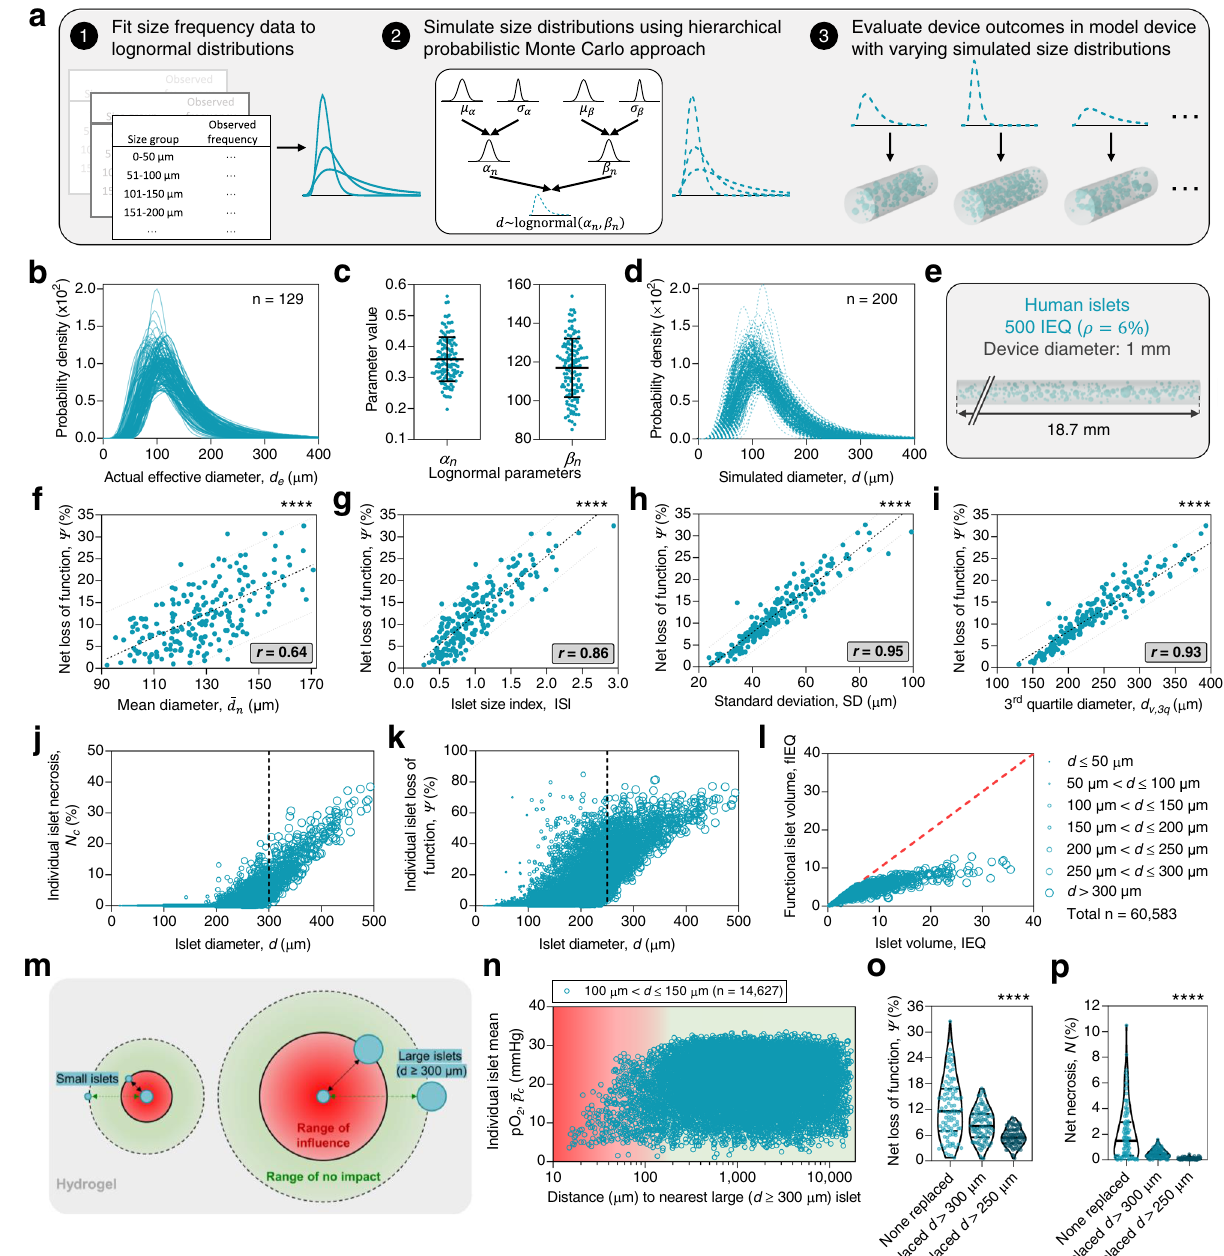
Fig. 3 | Variability in human islet size distributions in fl uences functional out- comes. a Schematic illustrating the procedure for calculating the effect of size distribution variability on BAP device functional outcomes. b Overlaid traces of humanisletdiameter probability density functions ( n =129 distributions). c Values of the number-basis shape and scale parameters ( α n and β n , respectively) from b ( n =129 values; bars represent mean±SD). d Traces of simulated human